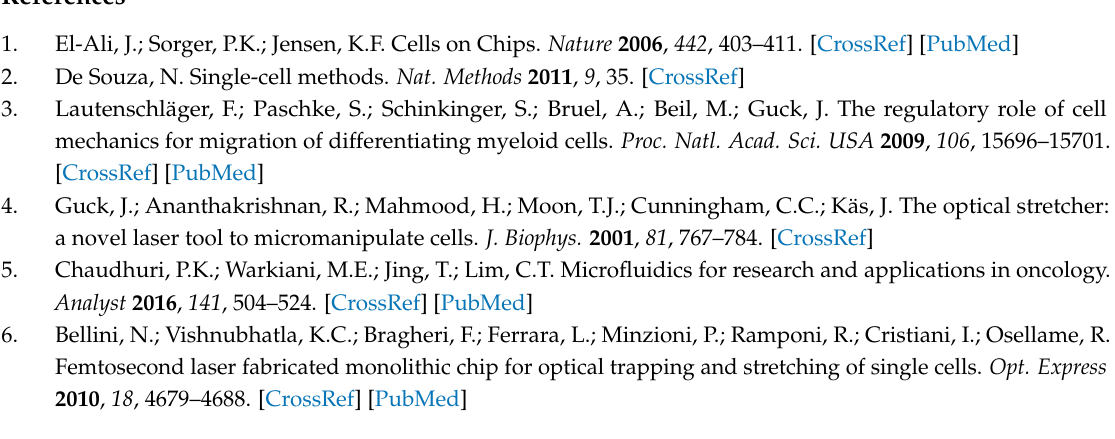
Figure 12. Sequence of frames of a stretched RBC (clearly elliptical). In the background is a non-trapped RBC (the arrow shows the flow direction). The non-trapped cell presents the typical circular profile of RBC in a hypotonic